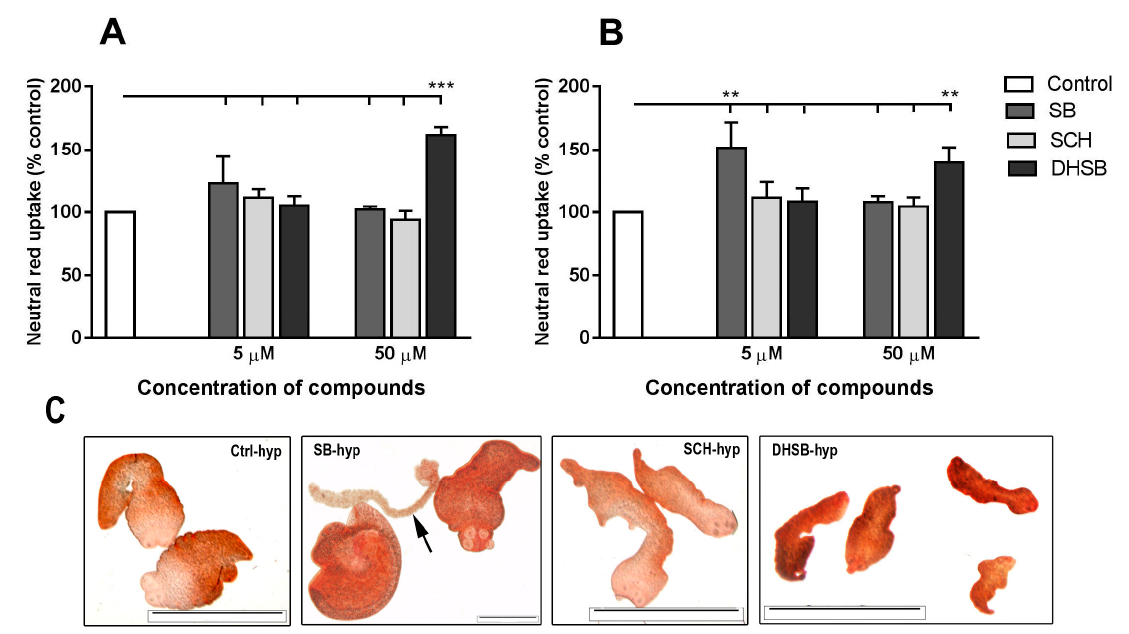
Figure 3. Viability of larvae measured by means of neutral red uptake after 72 h of incubation under aerobic ( A ) and hypoxic ( B ) conditions with SB, SCH and DHSB (5 µ M and 50 µ M). Results represent means ± SD from three experiments in triplicates/group and are expressed as the proportions (%) of absorbance in treated groups relative to the absorbance in the control group (100%). Significantly different values from controls are shown as ** p < 0.01, *** p < 0.001. ( C ) Representative images of live larvae from hypoxic cultivation after exposure to 50 µ M concentration of FLs. Note dead larva (arrow). Scale bar = 2000 µ M, Ctrl (control), (SB) silybin; (SCH) silychristin; (DHSB) dehydrosilybin.